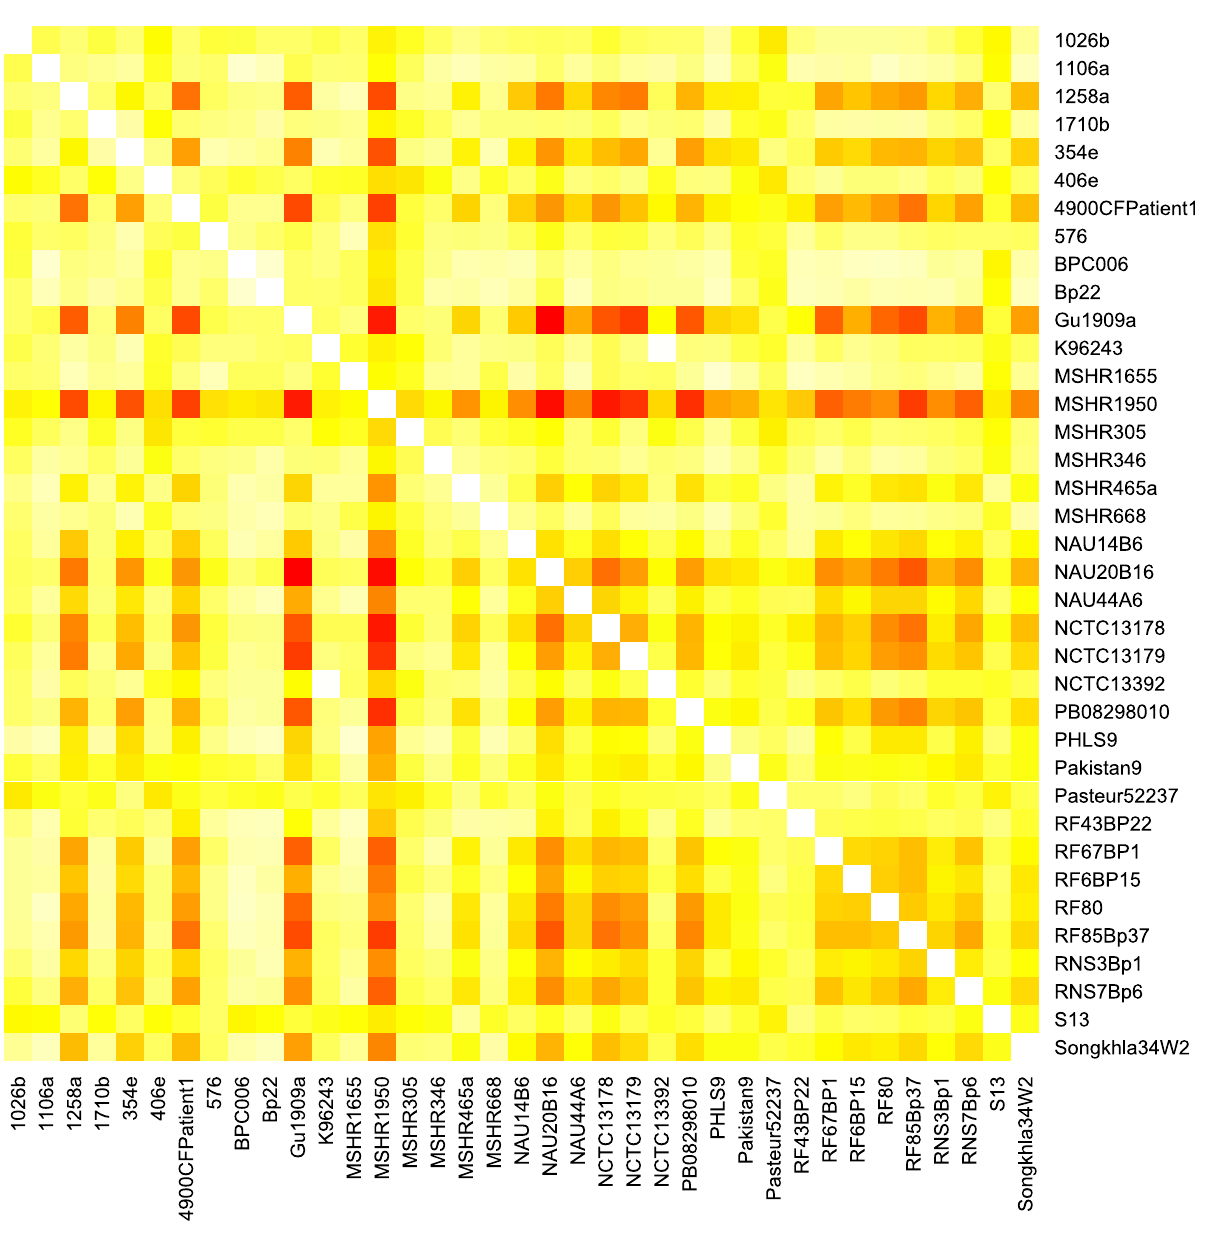
Fig 8. Pairwise values for gene order conservation. Reds indicate relatively low similarity of gene order and yellows, higher. All values are in the range 0.9089 < x <